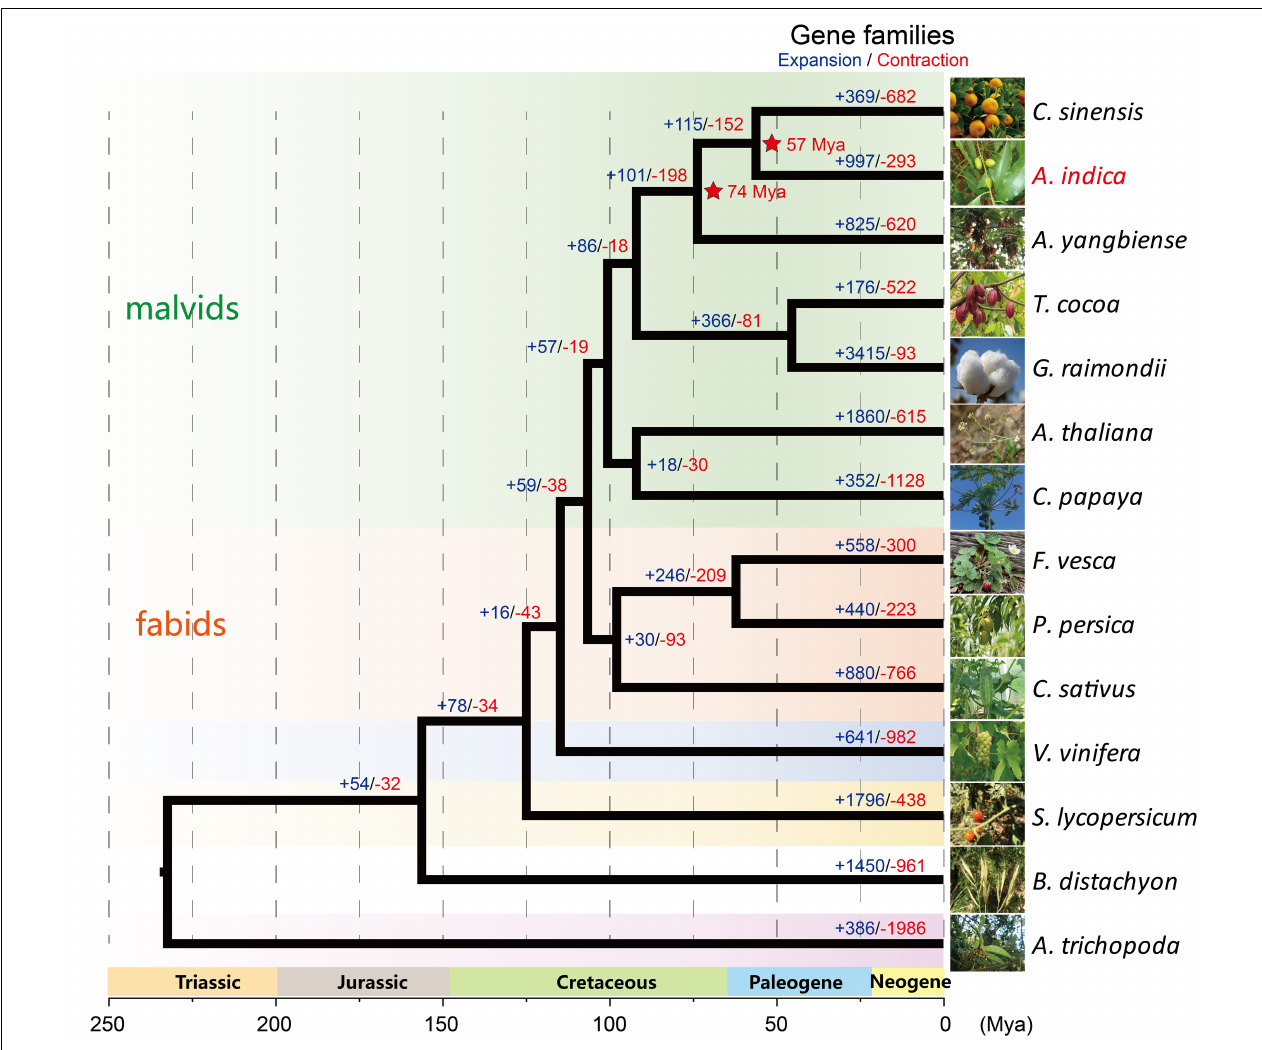
FIGURE 2 | Maximum Likelihood based phylogenetic analysis of A. indica and 13 other plant species using 1,338 single-copy orthologous genes with PhyML software (Guindon et al., 2009). The estimation of the divergence times (Mya; red; star) of A. indica with its closely related species are indicated. The number of expanded gene families (+; blue) and the number of contracted gene families (–; red) are shown in each